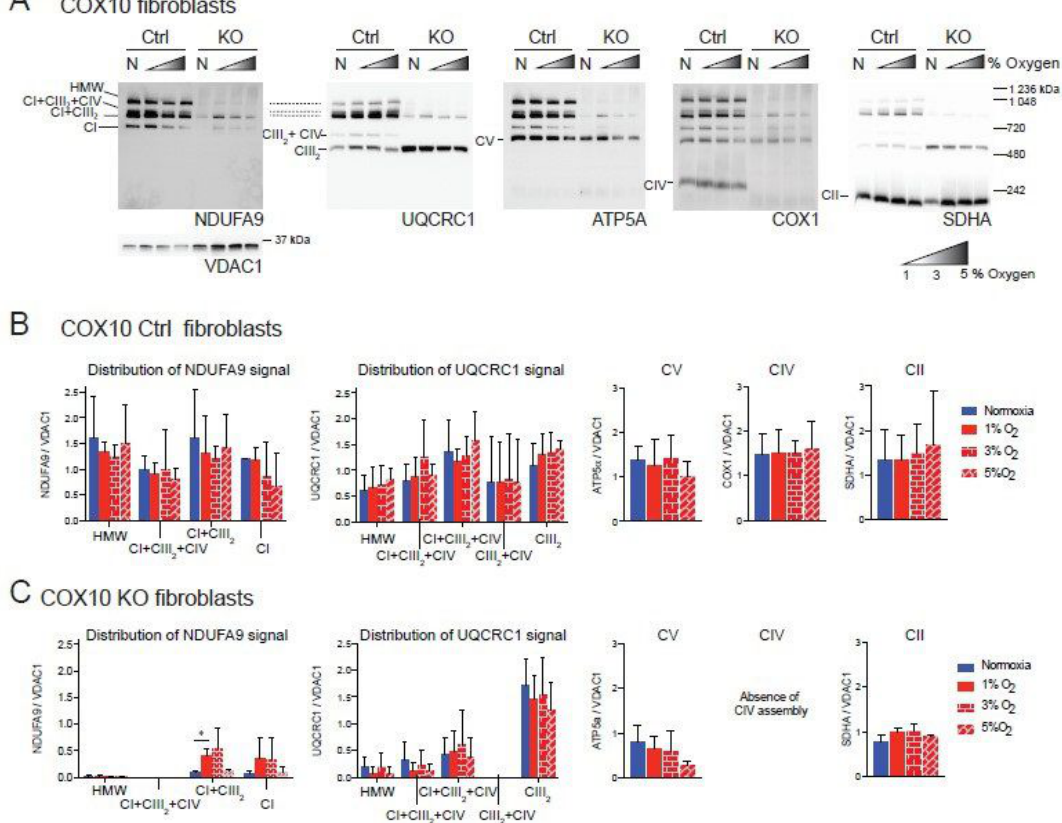
Figure 2. Blue native gel electrophoresis of COX10 murine fibroblasts exposed to di ff erent oxygen concentrations. ( A ) COX10 control and KO skin fibroblasts were exposed to normoxia (N, 21% oxygen), 1, 3 and 5% oxygen for 24 h. Mitochondrial proteins were extracted with digitonin and complexes and SCs analyzed by BN-PAGE followed by Western blot using antibodies against respiratory complex subunits. Shaded triangle represents hypoxic conditions of increasing oxygen concentrations (1, 3 and 5% oxygen). The positions of each respiratory complex (CI-CV) and SCs, as well as molecular weights, are indicated in the figure. SCs include high molecular weight (HMW), CI + CIII 2 + CIV, CI + CIII 2 and CIII 2 + CIV architectures. ( B ) Quantification of antibody signals of control lung fibroblasts shown in ( A ) of NDUFA9 (CI subunit), UQCRC1 (CIII subunit), ATP5A (CV subunit), COX1 (CIV subunit) and SDHA (CII subunit) normalized to the mitochondrial loading control VDAC1. Optical density of antibody signals in blots was calculated using the ImageJ software. ( C ) Quantification of antibody signals in RISP KO fibroblasts as indicated in ( B ). Graphs represent mean and standard deviation ( n = 2). Statistical significance among groups was determined by one-way ANOVA analysis followed by a Tukey’s multiple comparisons test where * p < 0.05 was considered statistically significant. Blue bars represent normoxia, red bars represent 1% O 2 , red horizontal brick pattern bars represent 3% O 2, and red diagonal brick pattern bars represent 5% O 2 . Antibodies were sequentially added on two identical blots in the following order, on blot 1: NDUFA9, ATP5A and COX1, on blot 2: UQCRC1 and SDHA. Exposure to 1–3% oxygen increased the levels of CI and CI + CIII 2 in COX10 KO